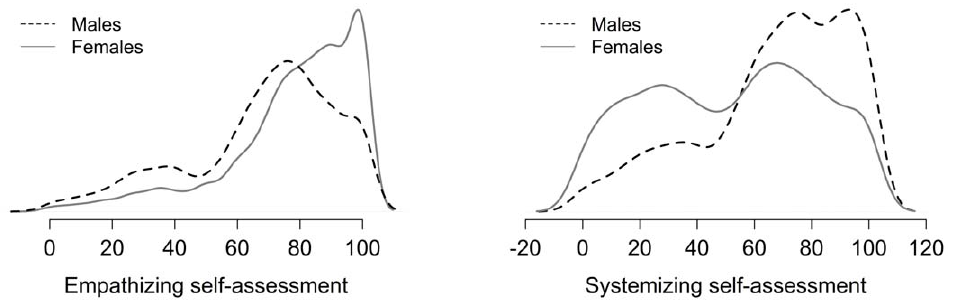
Figure 7. The distribution of mean responses for males and females for the self-assessed empathy ratings (left panel) and the self- assessed systemizing ratings (right panel). The distributions are drawn using a Gaussian kernel estimation method (the R default).